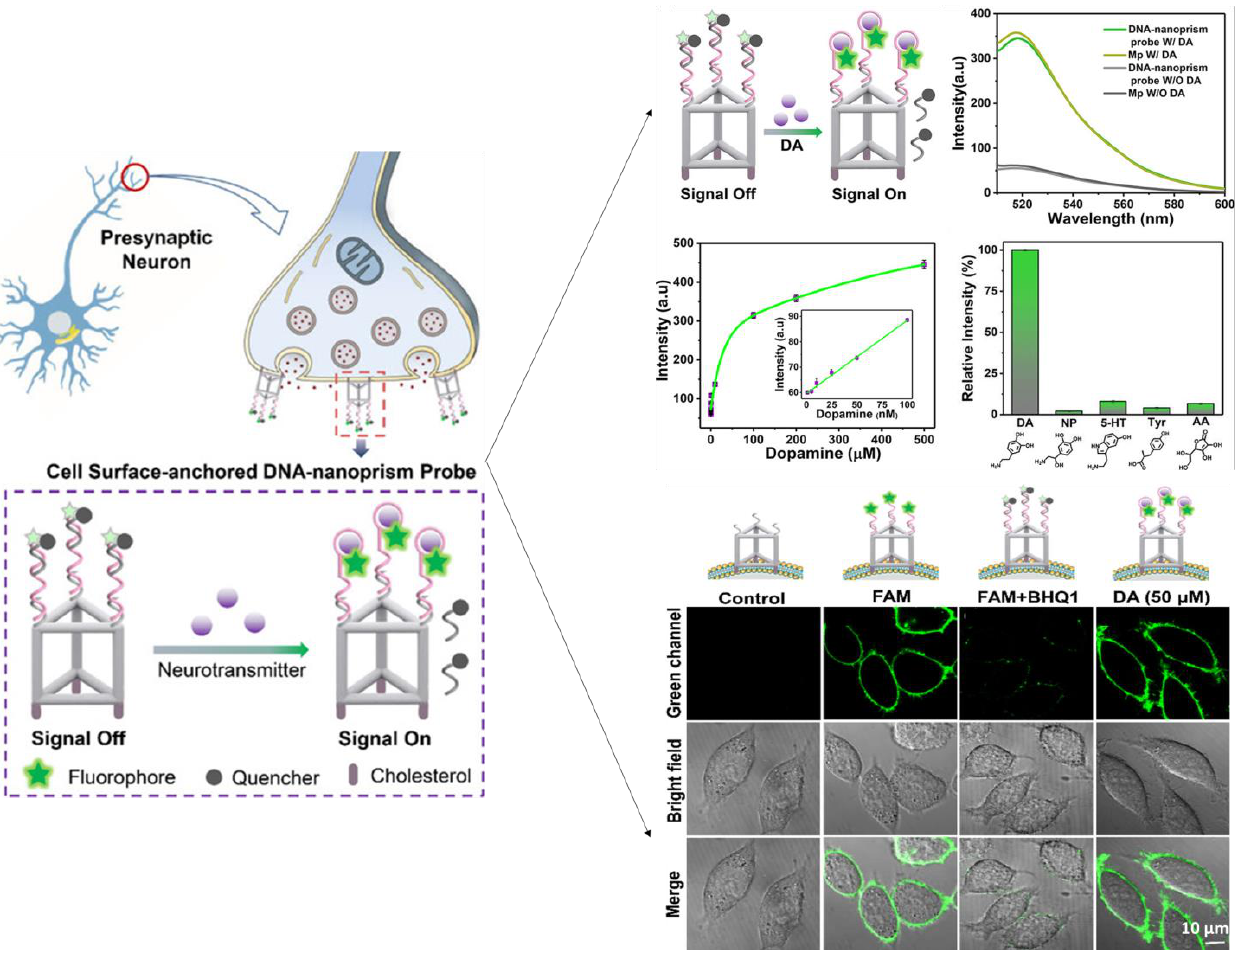
Figure 9. Schematic presentation of fluorescent biosensor with a Cell-Surface-Anchored DNA- Nanoprism for dopamine quantification release from live-cell. Reproduced with permission from [195]. Copyright 2020,